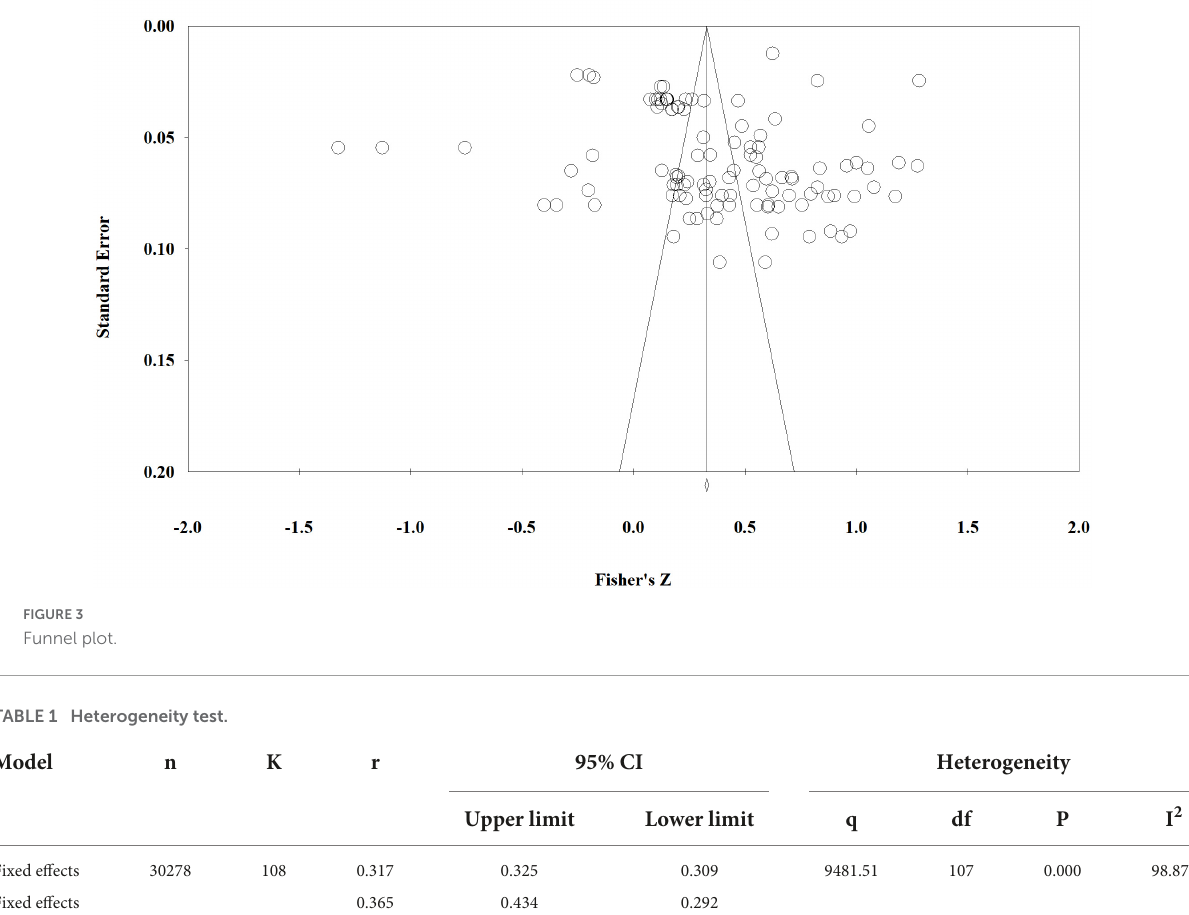
TABLE 1 Heterogeneity